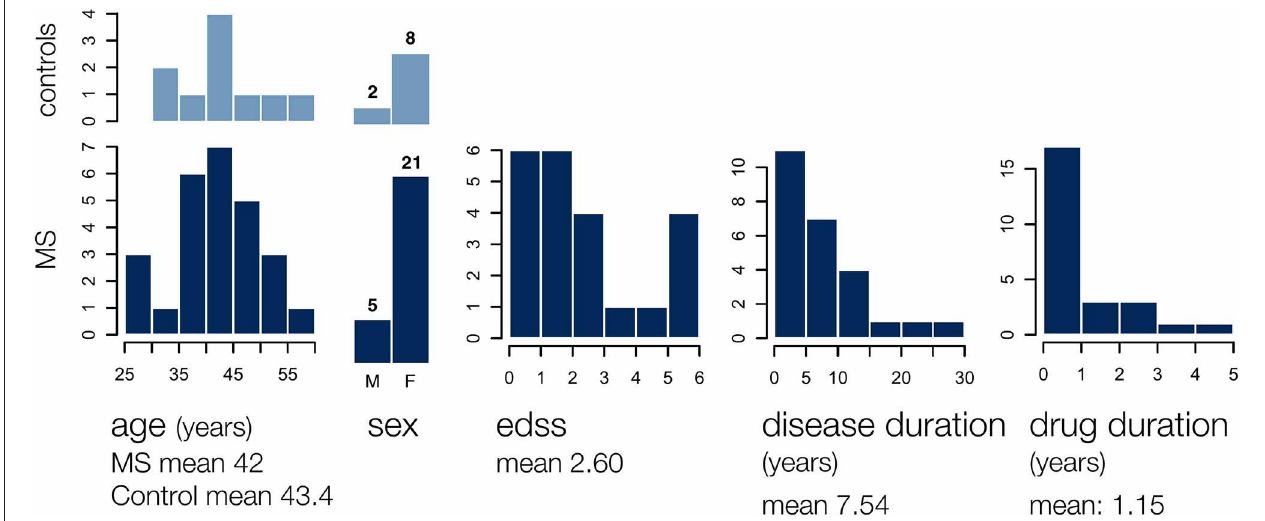
FIGURE 1 | The MS group participants included 5 males and 21 females of age 28–59 years, with an EDSS range of 0–6, a disease duration of 0.5–28 years, and a glatiramer acetate use duration of 0–5 years. Demographics for 10 age and gender matched controls are also shown.